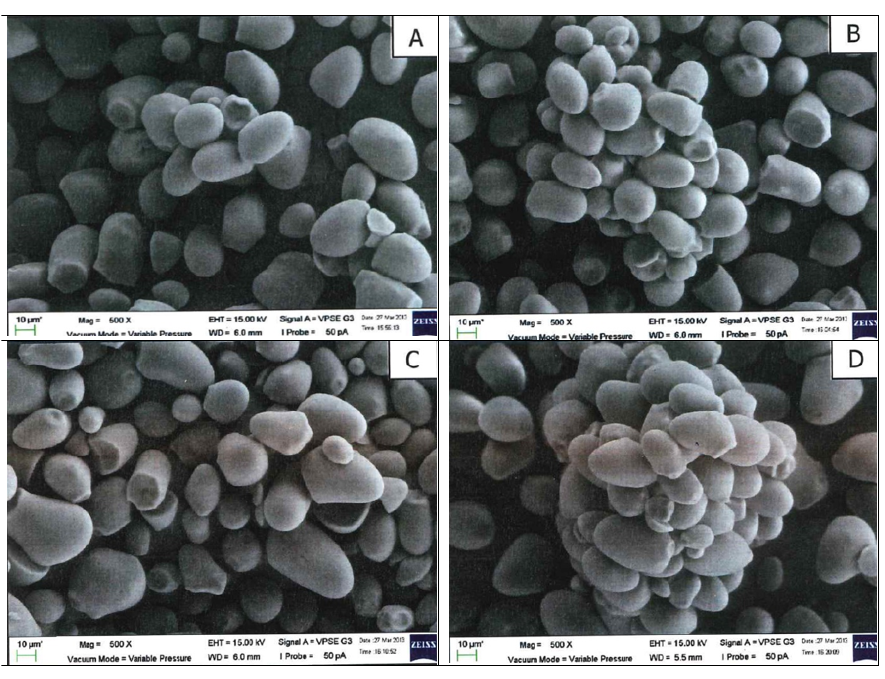
Figure 4. Scanning electron micrographs for ( A ) 5kGyANN(T o -10); ( B ) 10kGyANN(T o -10); ( C ) 25kGyANN(T o -10); ( D ) 50kGyANN(T o -10) (500×